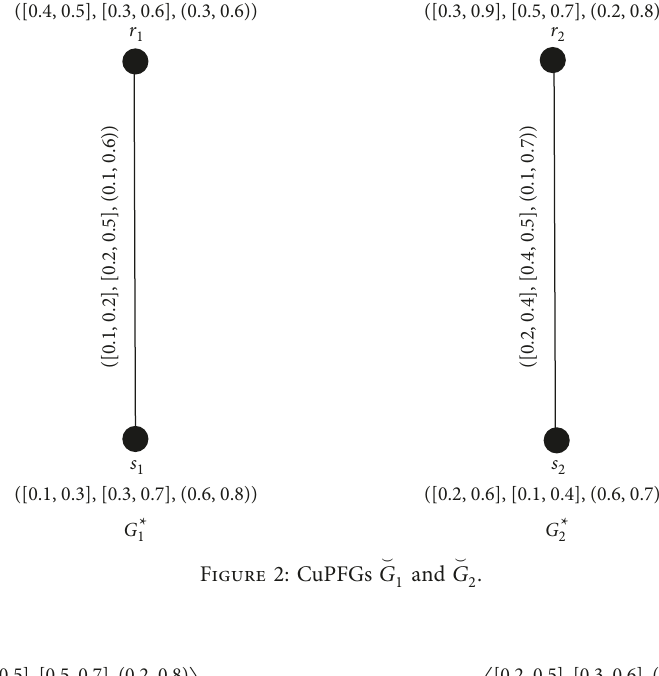
Figure 2: CuPFGs G ⌣